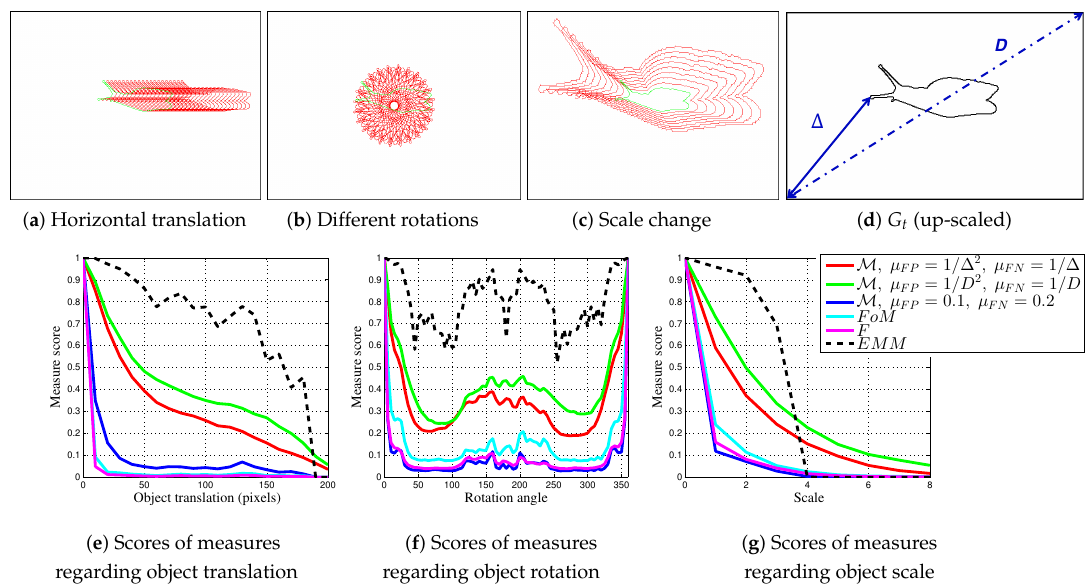
Figure 4. Examples behaviors of localization metrics for translation, rotation, and scale alterations. In ( a – c ), red points represent the shape at a particular position, whereas the green points correspond to the true shape position (i.e., G t ). Several parameters for M are tested: ∆ represents the maximum distance between a pixel in D c with G t (usually an image corner pixel), whereas D is the length of the image diagonal. Parameters D and ∆ are calculated automatically and D > ∆